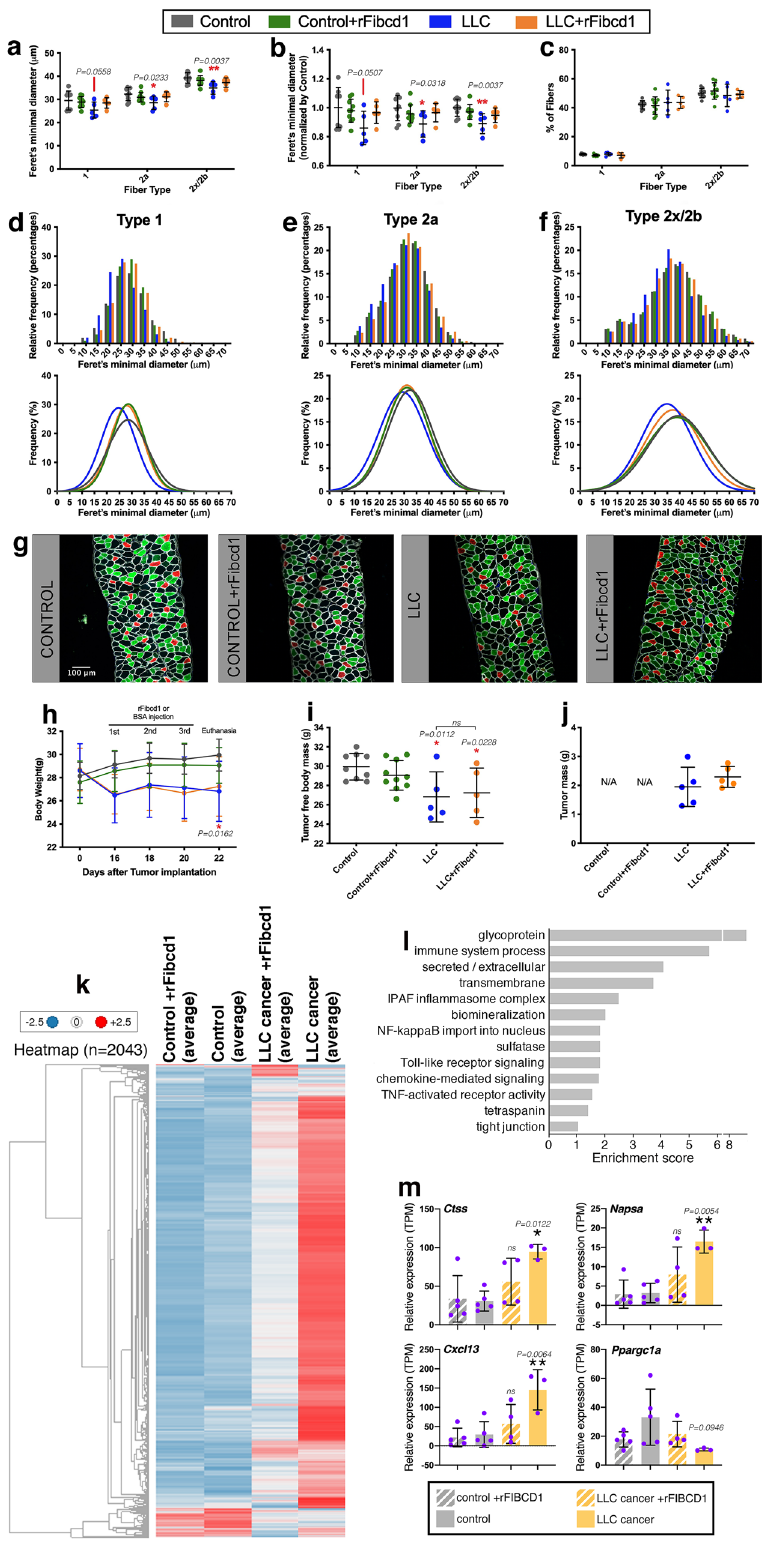
By examining the size of myo fi bers in the diaphragm muscle of these mice, we found that the cachectic melanoma induces signi fi cant atrophy, as indicated by the average Feret ’ s minimal diameter, compared to mice injected with a control